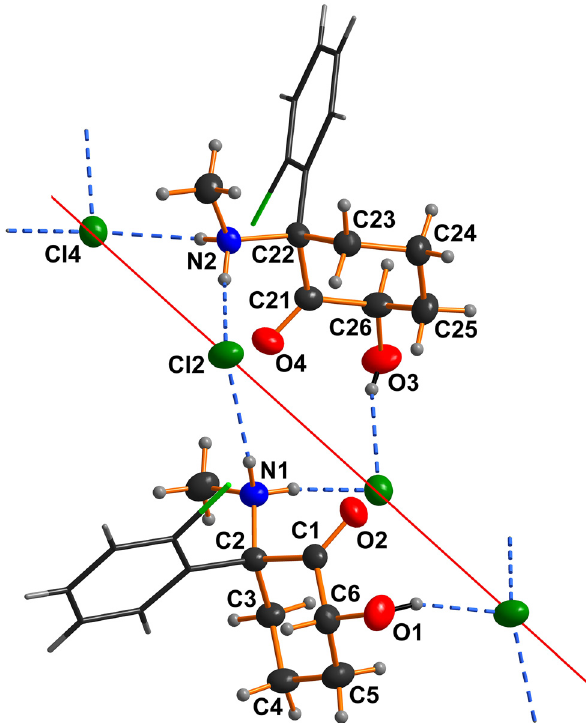
Table  : Data collection and